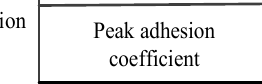
Figure 5. Road recognition principle.